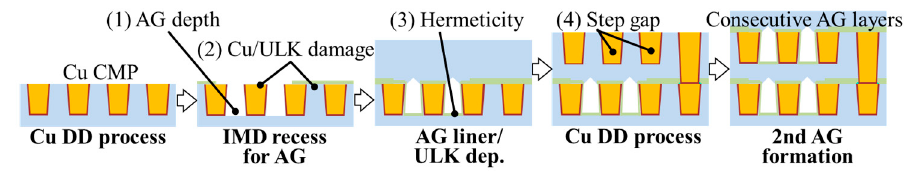
Figure 2. Conventional AG process flow.